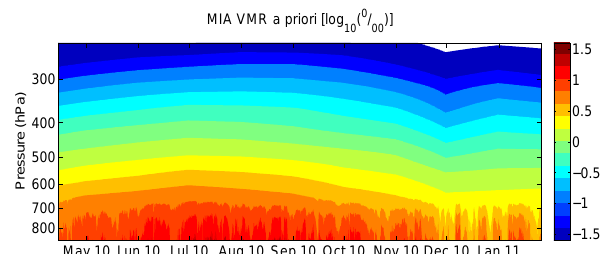
Fig. 5. A-priori H 2 O volume mixing ratio profile combined from a climatology and the actual surface vmr measured from Zimmerwald weather station as used for retrieval version 4 (2h averaged spectra) for April 2010–January 2011.